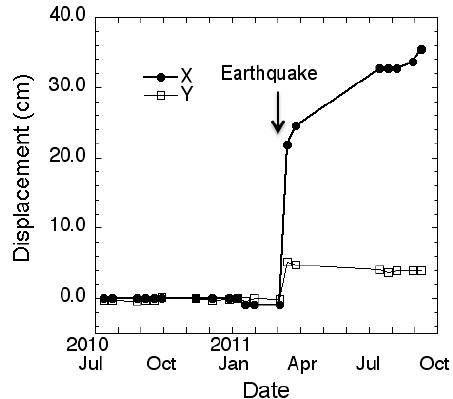
Figure 2. Absolute displacement from June 22, 2010 observed at GEONET Kawasaki ground station. The 20 plots from July 3, 2010 to September 5, 2011 correspond to the acquisition date of TerraSAR-X data